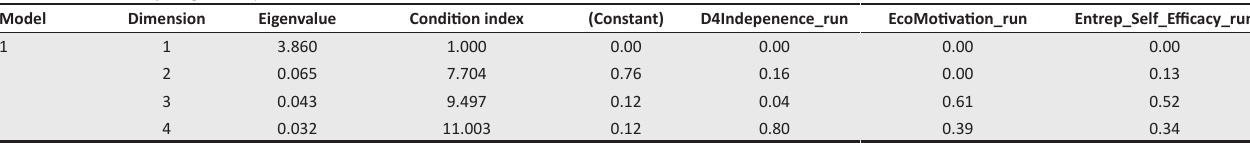
TABLE 4-A1: Collinery diagnostics † . Model Dimension